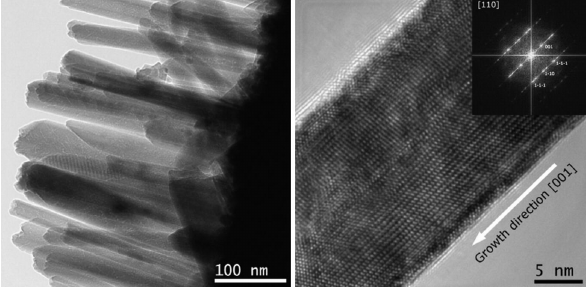
Figure 1: Bright field image of ZrO 2 nanobars (20 M NaOH); HRTEM image of zirconia nanobar (25 M NaOH) [43]